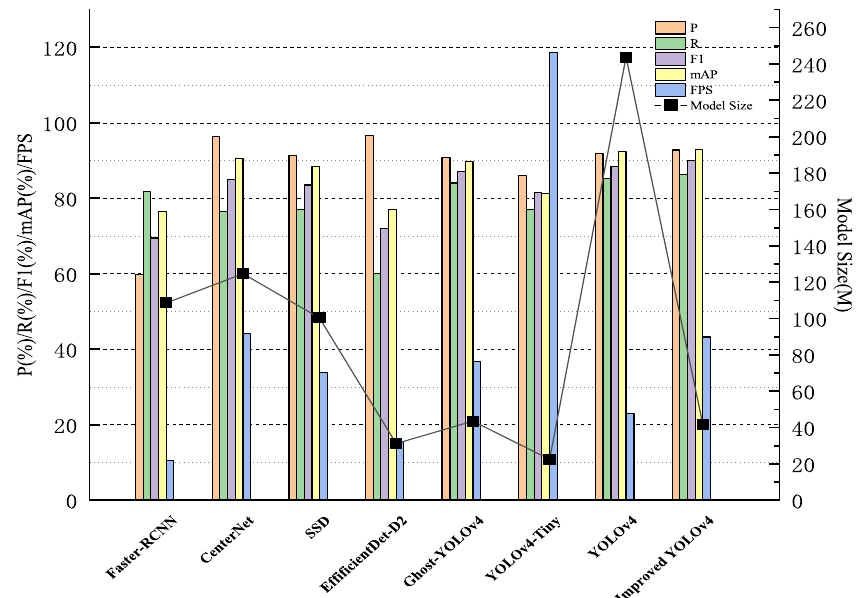
Figure 10. Comparison of histograms of the test results of different algorithms.